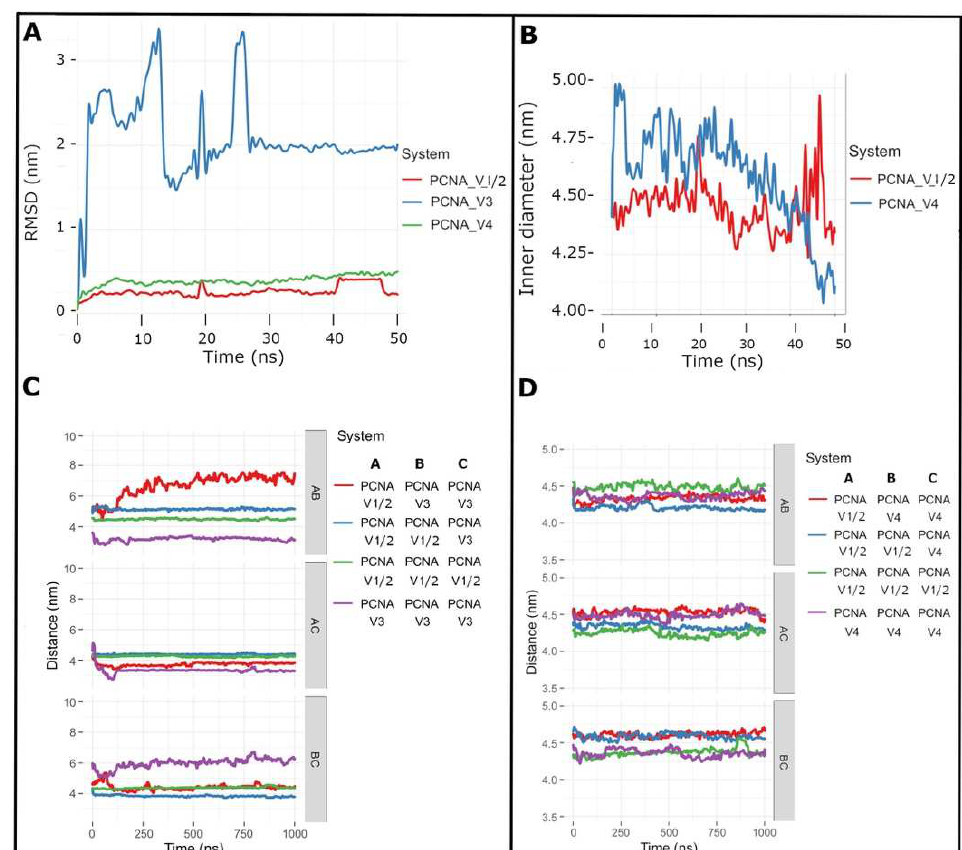
Figure 5. Computational analysis of different PCNA trimers. ( A ) PCNA protein (PCNA_V1/2) shows great structural stability in the system. The reduced PCNA_V3 resulted in a large conformational change in solution (blue line). Notice that PCNA_V4 (green line) is similar to the PCNA native structure. ( B ) PCNA_V4 presents a greater variability of the internal diameter of the homotrimer, which is relevant to the stability of the PCNA-DNA complex. ( C ) PCNA_V3 with native PCNA tends to form dimers with a highly variable structure ( A , B , red line). Distances are shown in pairs: AB, AC and BC. Depending on the color, the distance of the analyzed pair is indicated; for example, the red line analyzes the heterotrimer formed by a native PCNA monomer ( A ) and a variant PCNA dimer ( B , C ), the same as for the blue line, the heterotrimer formed by a native PNCA dimer ( A , B ) and a variant PCNA monomer ( C ). The green and purple lines correspond to the homotrimers of native PCNA (green) or variant PCNA (purple). ( D ) PCNA_V4 and the native state protein tended to form stable homotrimers with a similar distance during the simulation time.